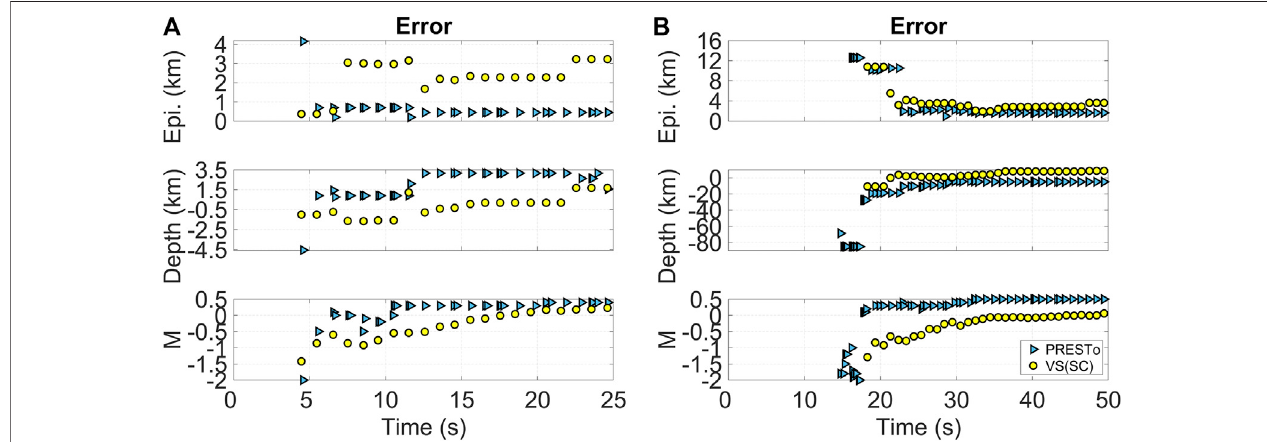
FIGURE 3 | Temporal evolution (starting from the origin time) of the estimates by the PRESTo and VS(SC) algorithms for two example earthquakes: (A) the 2000- 06-17 observed event in South Iceland; and (B) the 2016-09-23 observed event in Vrancea. Top: epicentral error timeline; middle: depth error timeline; and bottom: magnitude (M) error timeline. All error values are computed by subtracting the bulletin values from the corresponding estimates of the algorithms. Different symbols distinguish the two algorithms.